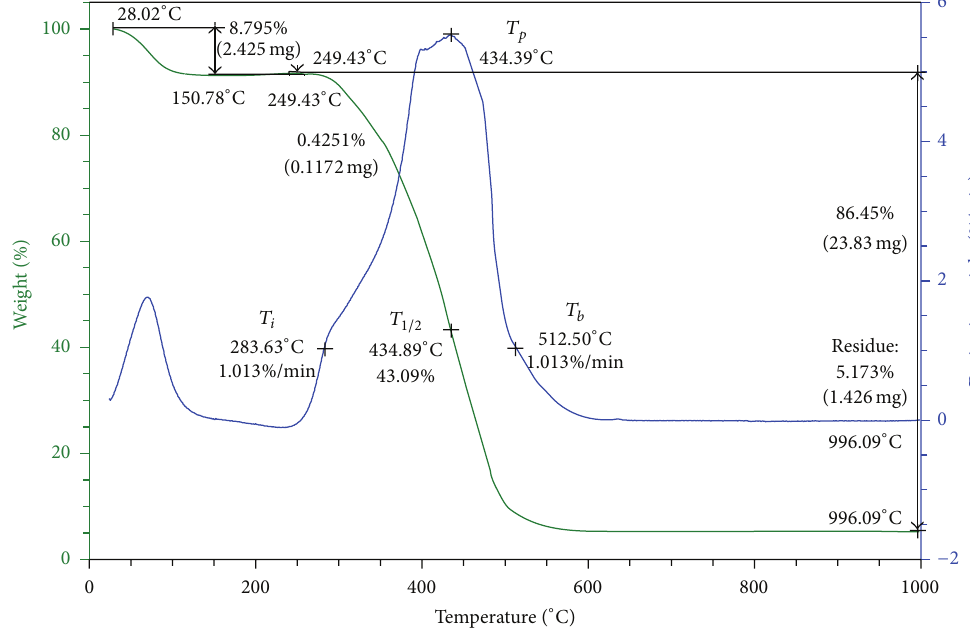
Figure 7: TGA/DSC combustion thermogram for Ezimo coal.